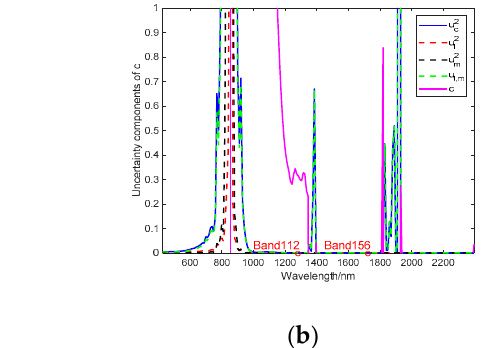
Figure 7. Absolute uncertainty and relative uncertainty of parameter c . ( a ) Relative uncertainty; ( b ) absolute uncertainty and its components. In subplot ( b ), the blue solid line is the combined variance of c ; the dashed lines are the uncertainty components associated with intercept l (red), slope m (black), and the correlation component between l and m (green); the pink solid line is the value of c .